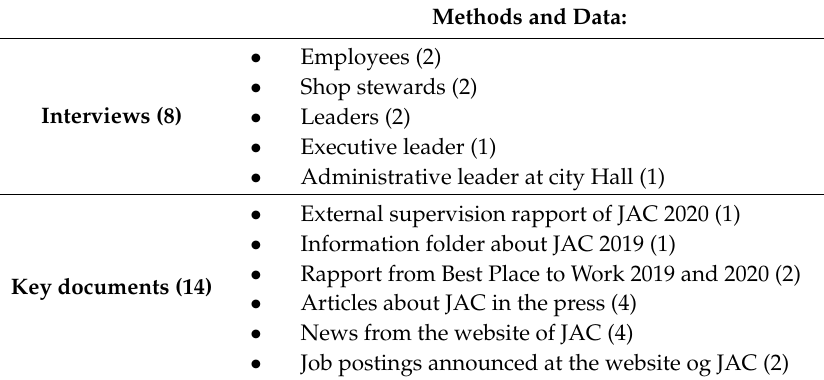
Table A1. Overview of data